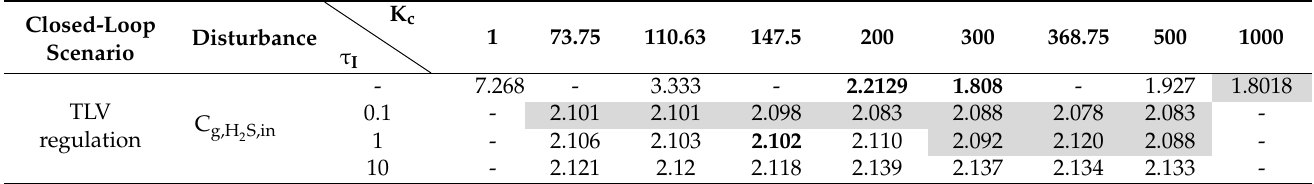
Table 6. IAE criteria result for the trickling liquid velocity (TLV)-CL when H 2 S inlet concentration is the disturbance of the system. Values in bold represent the selected parameters and values shaded in gray provided an oscillatory response of the final control element.